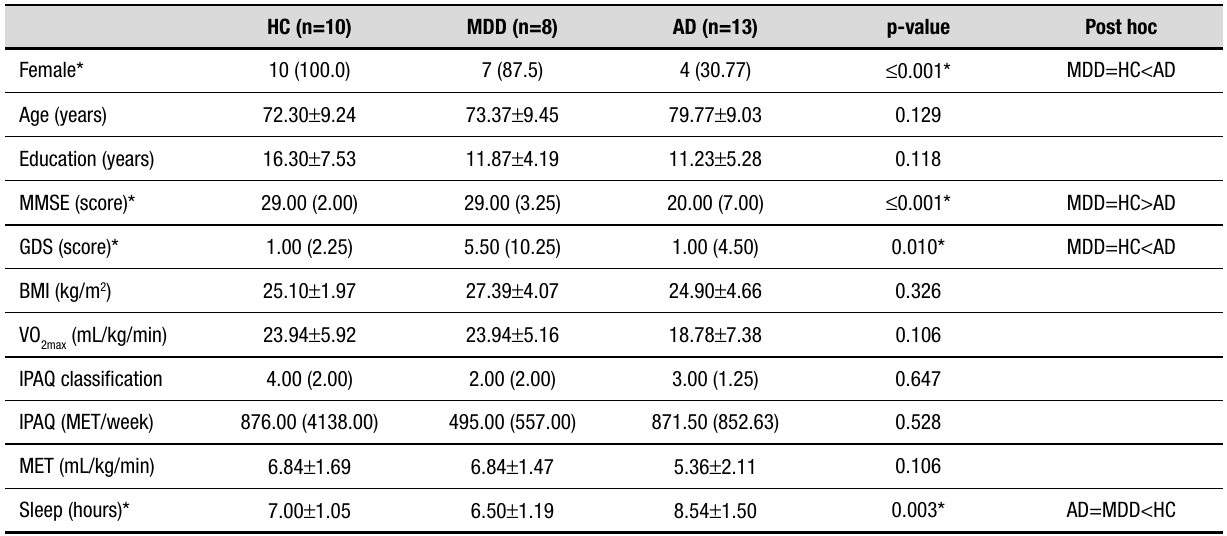
Table 1. Descriptive characteristics of the sample in